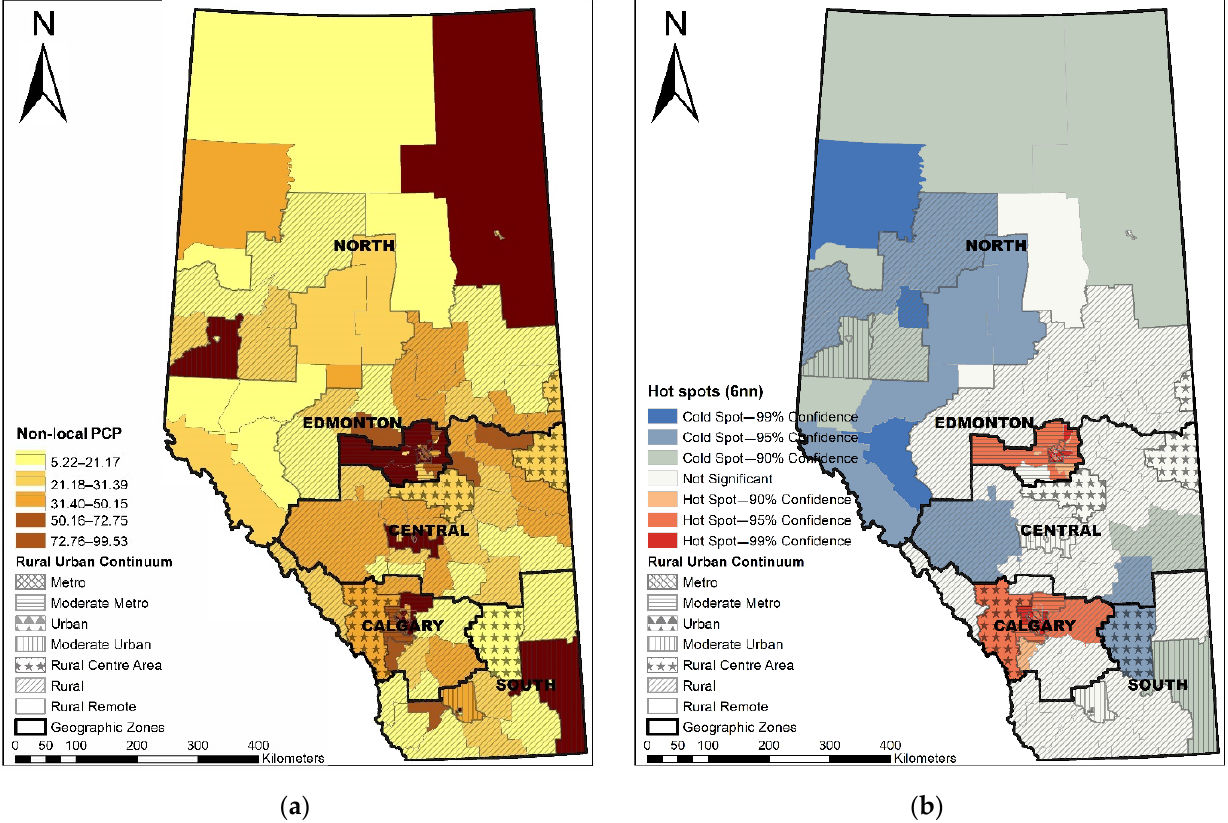
Figure 2. Distribution of non-local PCP utilization ( a ) and hot spots and cold spots of non-local PCP utilization ( b ) in Alberta.